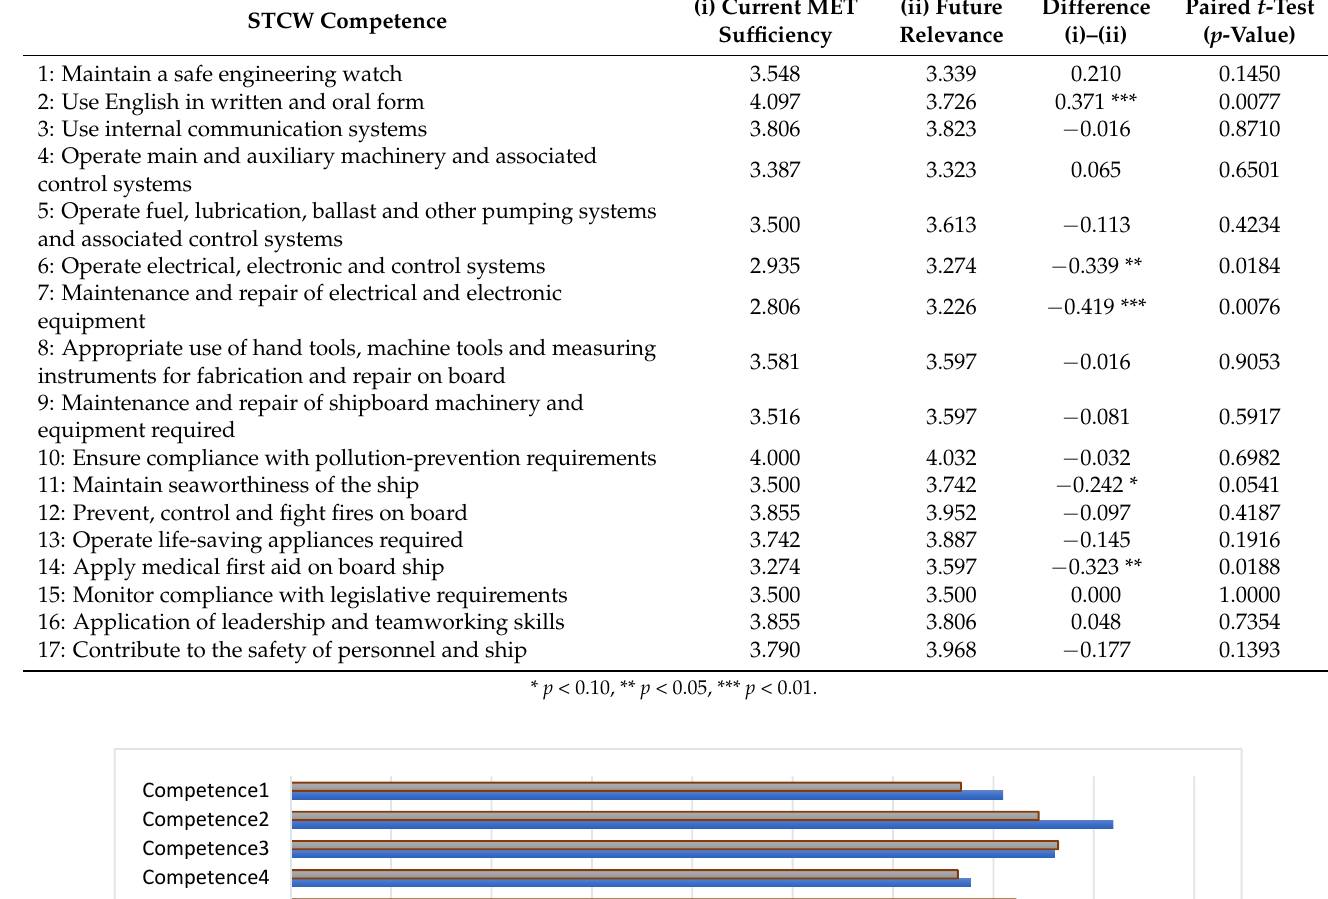
Table 3. Comparison of mean scores of statements related to STCW competence. STCW Competence